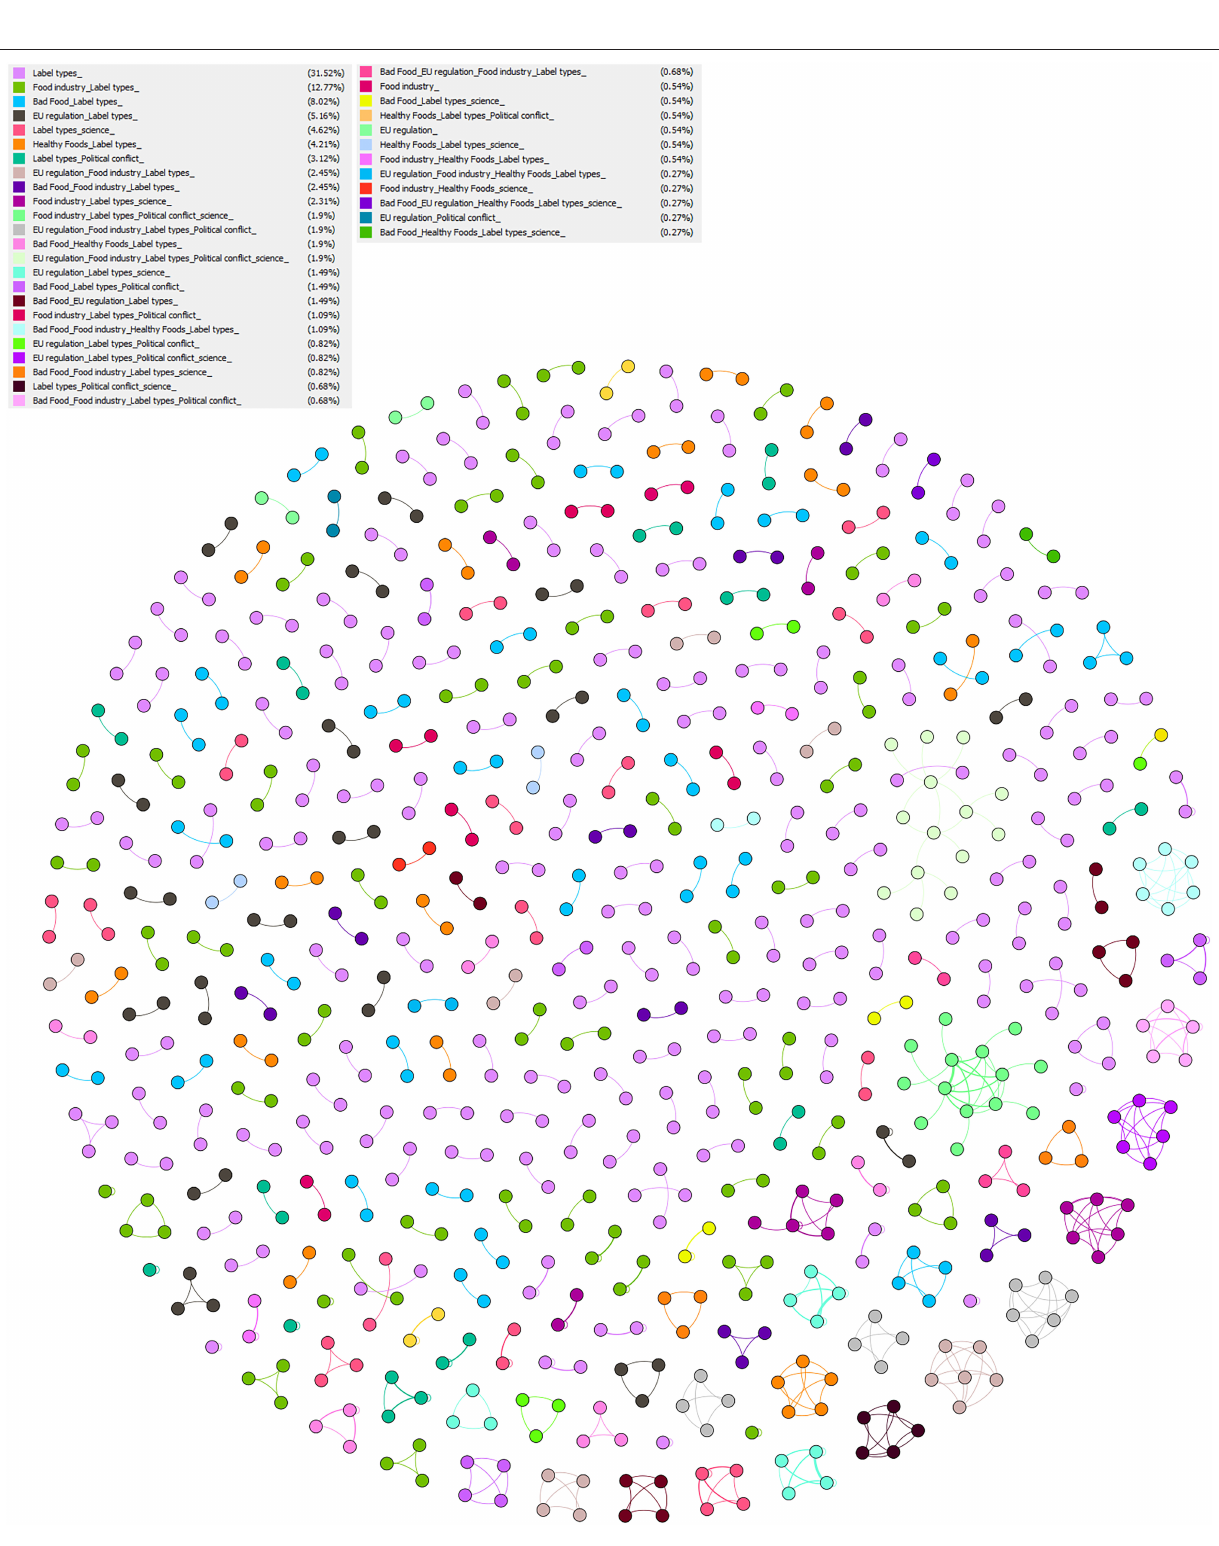
FIGURE 3 | Network analysis of dialogues. The Fruchterman–Reingold layout algorithm shows tweets belonging to dialogues and having similar conversation IDs. The dialogues were represented by colors, each corresponds to the different themes in which the dialogues were coded. The nodes (tweets) are connected by lines, representing their